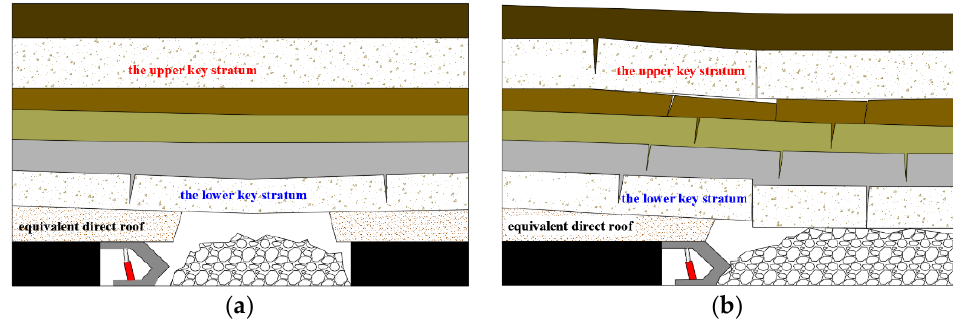
Figure 4. Schematic diagram of roof fracture of multi-key layer structure ( a ) initial weighting process ( b ) period weighting process.